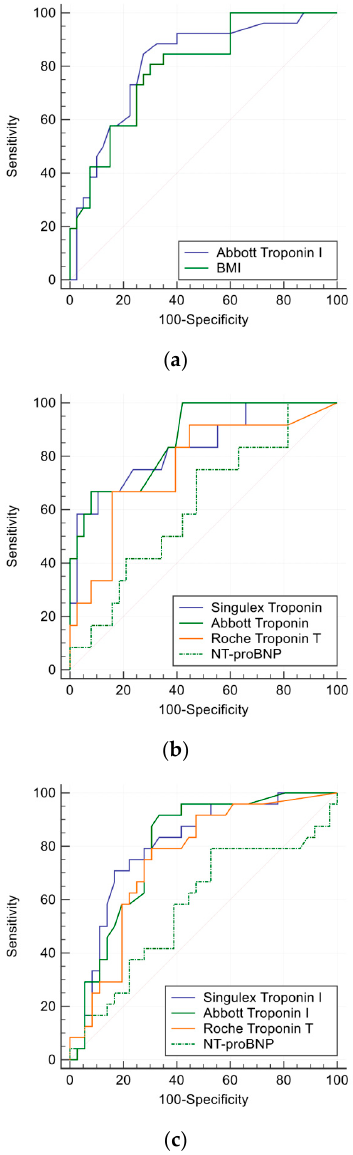
Figure 2. Receiver-operative characteristics analyses curves: ( a ) comparing Abbott troponin I and body mass index in prediction of LVH Echo , ( b ) biomarkers predictive of LVH Echo , ( c ) biomarkers predictive of LVH